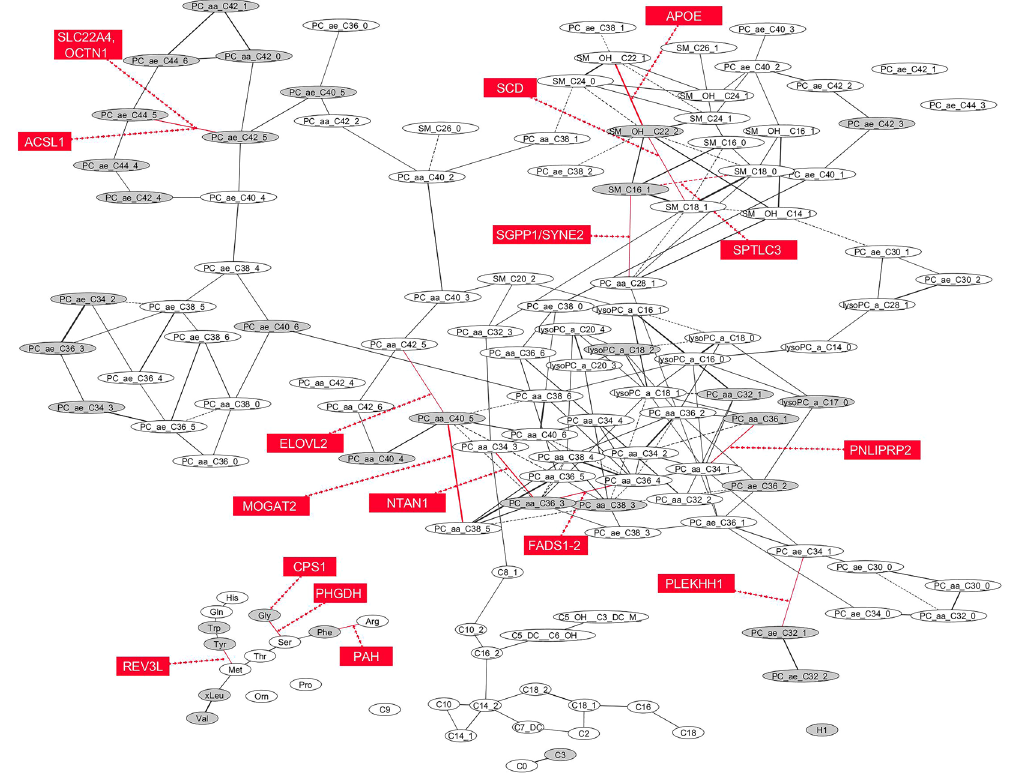
Figure 2. Network structure of metabolites within EPIC-Potsdam and related genetic variants. 34 diabetes associated metabolites are depicted in grey elipses; sixteen identified genetic variants associated with diabetes- related metabolite traits are depicted in red rectangles (only the top associated metabolite trait is depicted for each locus); solid line indicates direct association between metabolites; dashed line indicates inverse association between metabolites; GGM network was adapted from the publication by A. Floegel et al . 53 and drawn by using Cytoscape Software v3.2.1 66 .